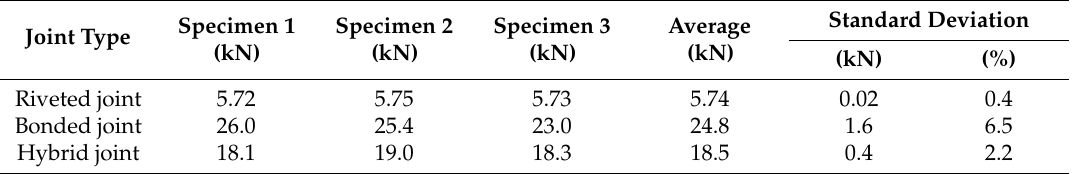
Figure 4. Experimental load vs. displacement curves for riveted, adhesive bonded, and hybrid joints for ( a ) composite-composite and ( b ) composite-metal configurations. Table 5. Experimental results for strength of riveted, adhesive bonded, and hybrid joints with composite substrate and composite doublers.